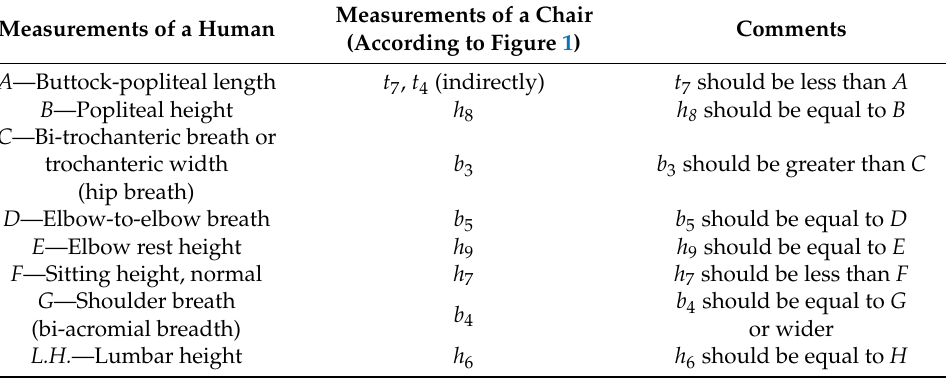
Table 1. The links between the measurements of a man and functional dimensions of a chair. Measurements of a Chair Measurements of a Human (According to Figure 1)